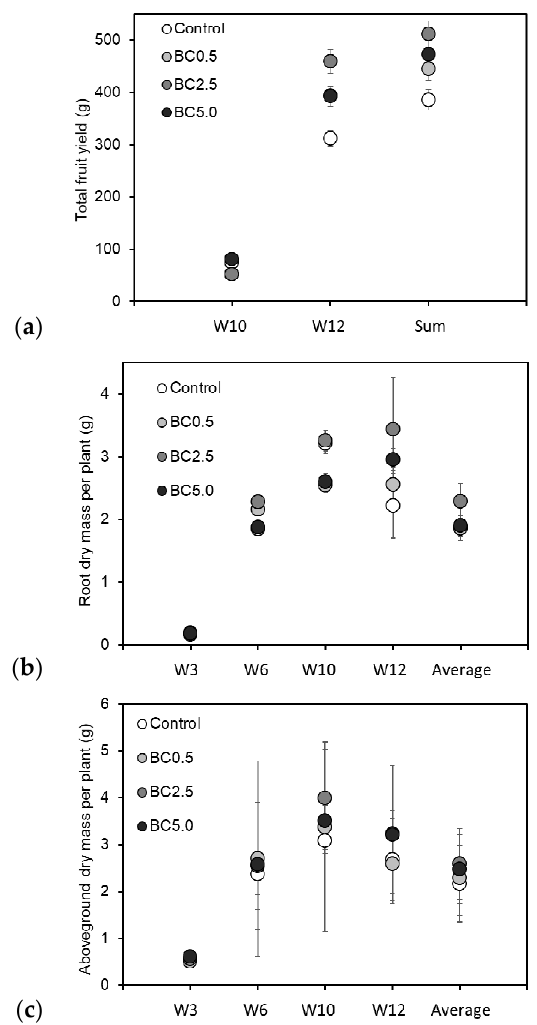
Figure 3. Measurements of the ( a ) fruit yield, ( b ) root dry mass, and ( c ) total aboveground biomass (dry weight) per pepper plant over time. W represents the weeks after beginning of the experiment. W3, W6, and W10 n = 2, W12 n = 8 plants; Mean ± SD.